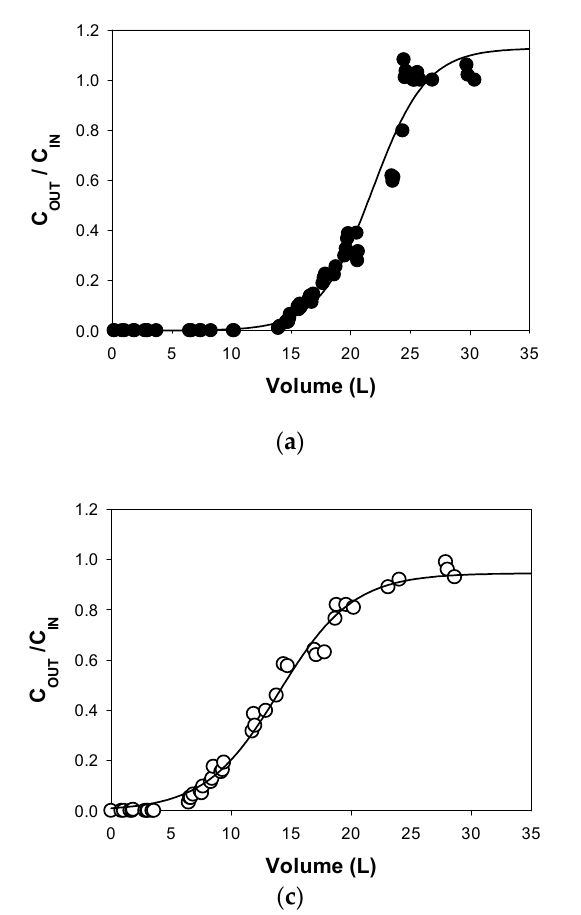
Figure 6. Breakthrough curves of TCE onto ( a ) PWBC; ( b ) RHBC and ( c ) EuFeBC. Fixed-bed reactors treated about 0.8 L die − 1 and about 25 pore volume per